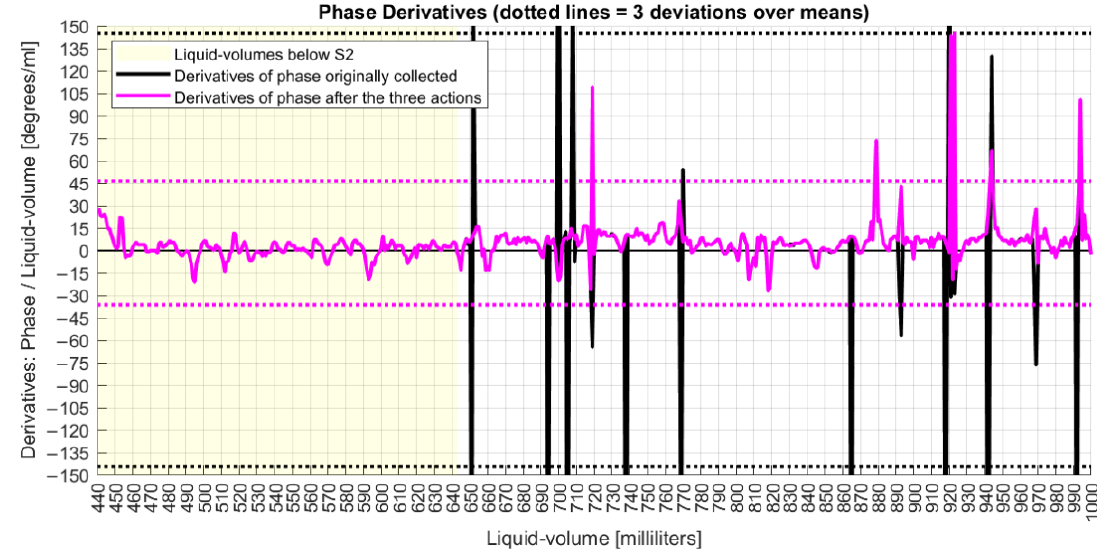
Figure 12. Derivative analyses of phase signals before and after corrections.